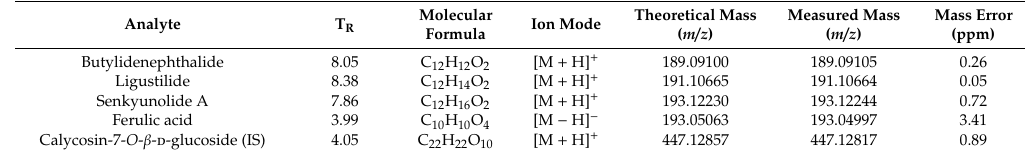
Table 1. Mass spectrometric analysis parameters of four analytes and IS.